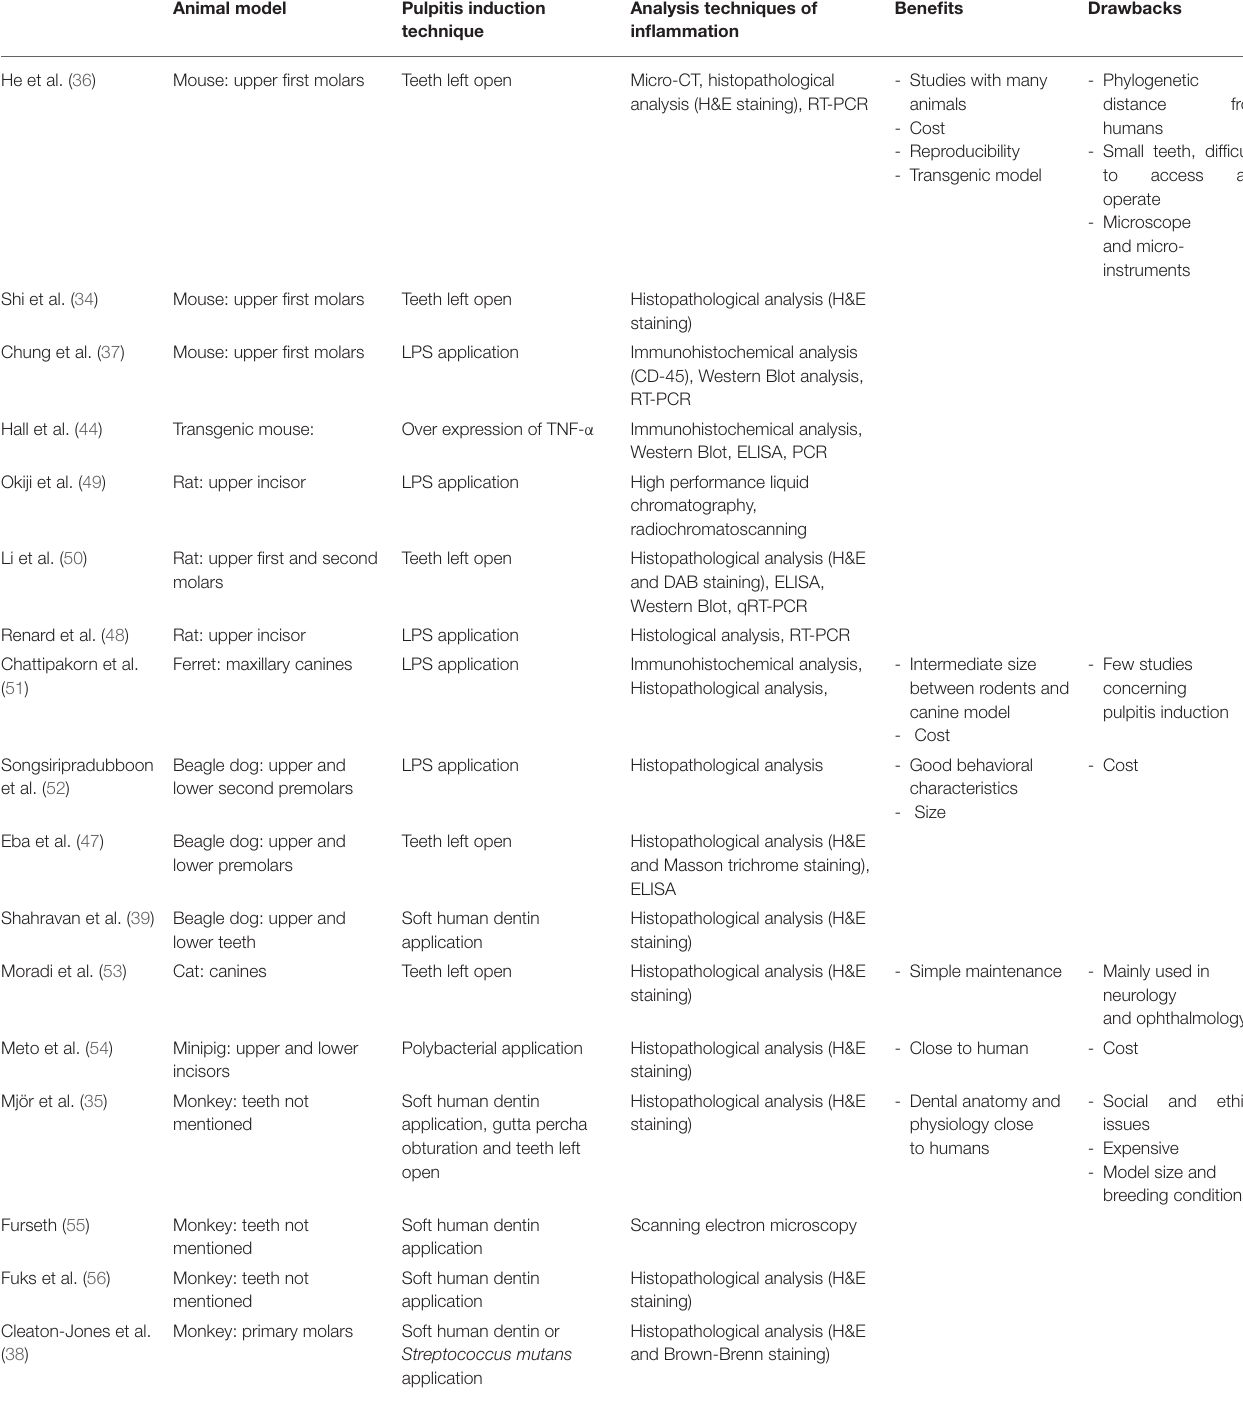
TABLE 1 | Summary of pulpitis animal